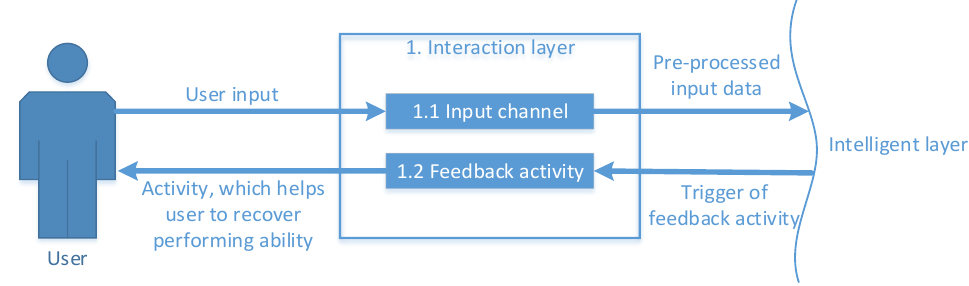
Figure 3. Communication between user and the interaction layer of HA-HCI.